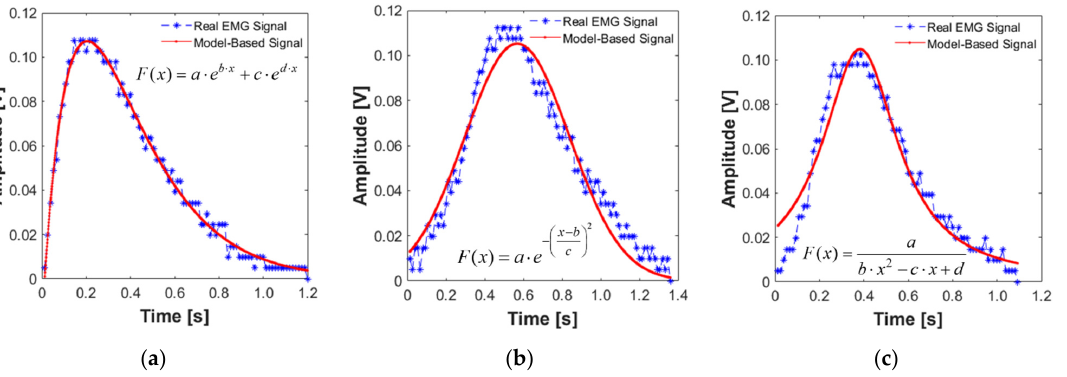
Figure 4. Real and model-based EMG signals: ( a ) first movement (Exponential model); ( b ) second movement (Gaussian model); ( c ) third movement (Fractional model). movement (Gaussian model); ( c ) third movement (Fractional model).